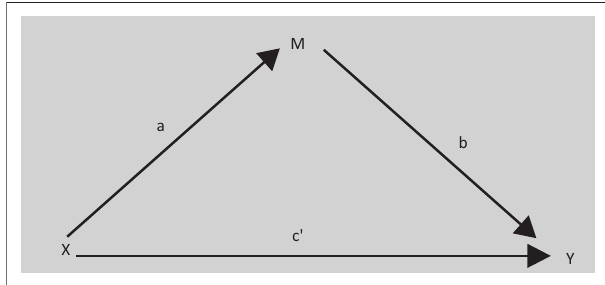
FIGURE 2: A simple mediation model effect.